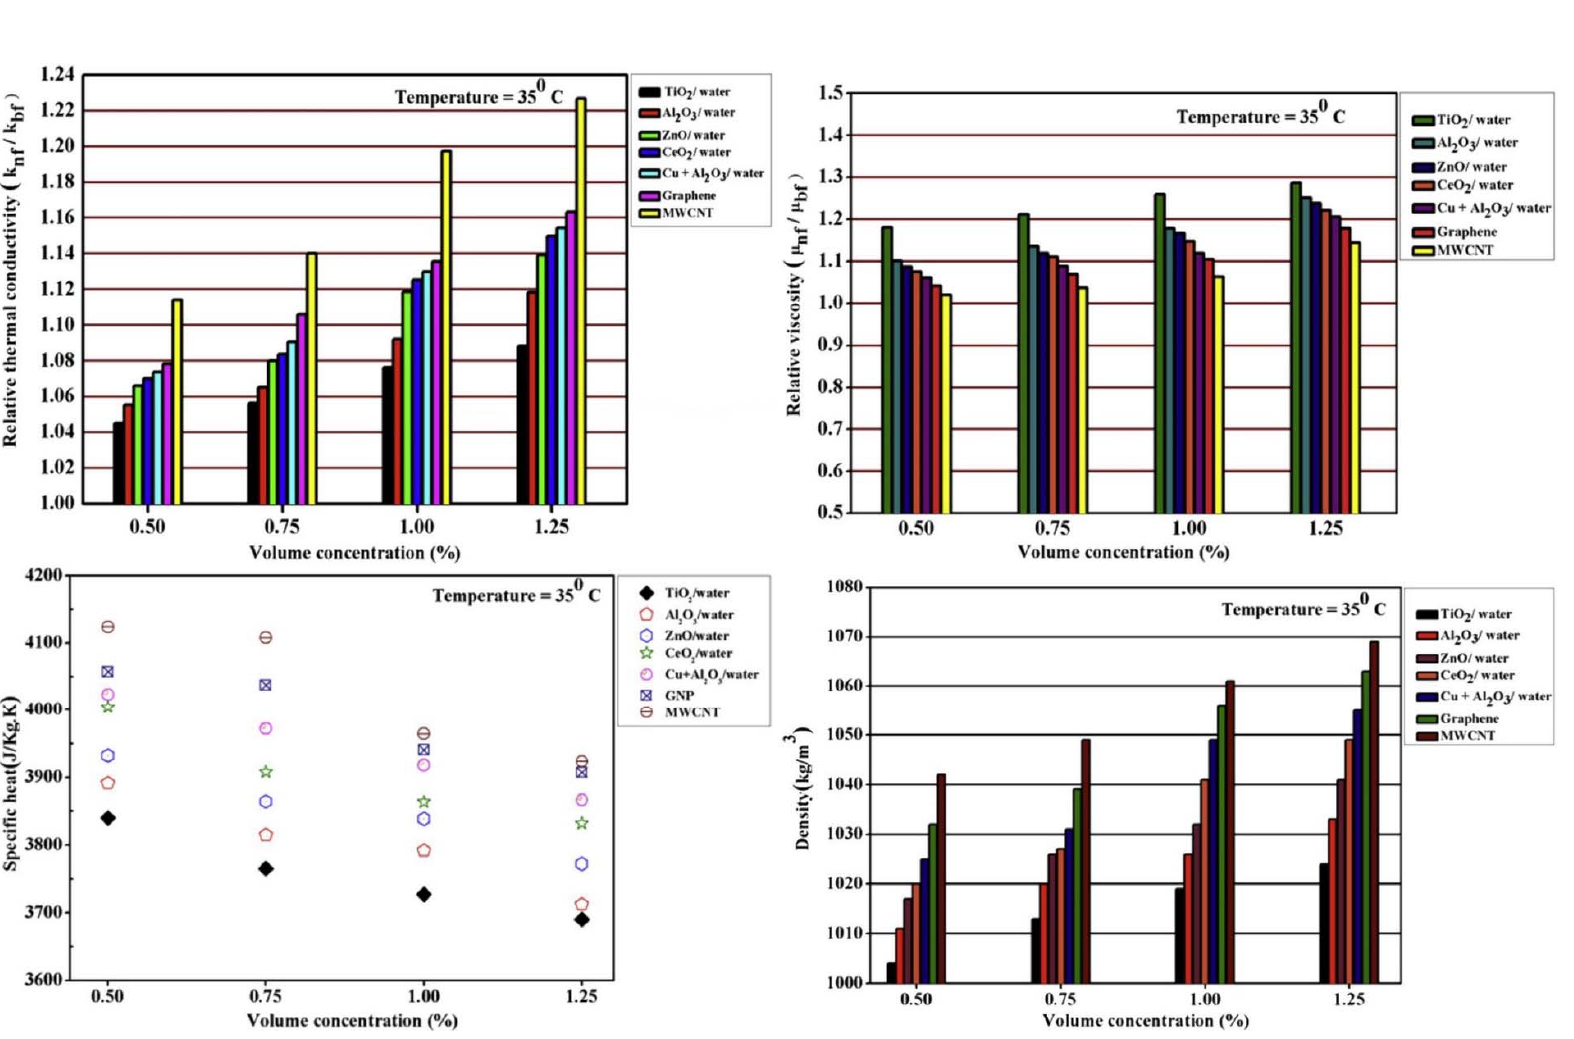
Figure 12. Variation of the relative thermophysical properties of the studied nanofluids. Reproduced with permission from [183]. Elsevier, 2016.